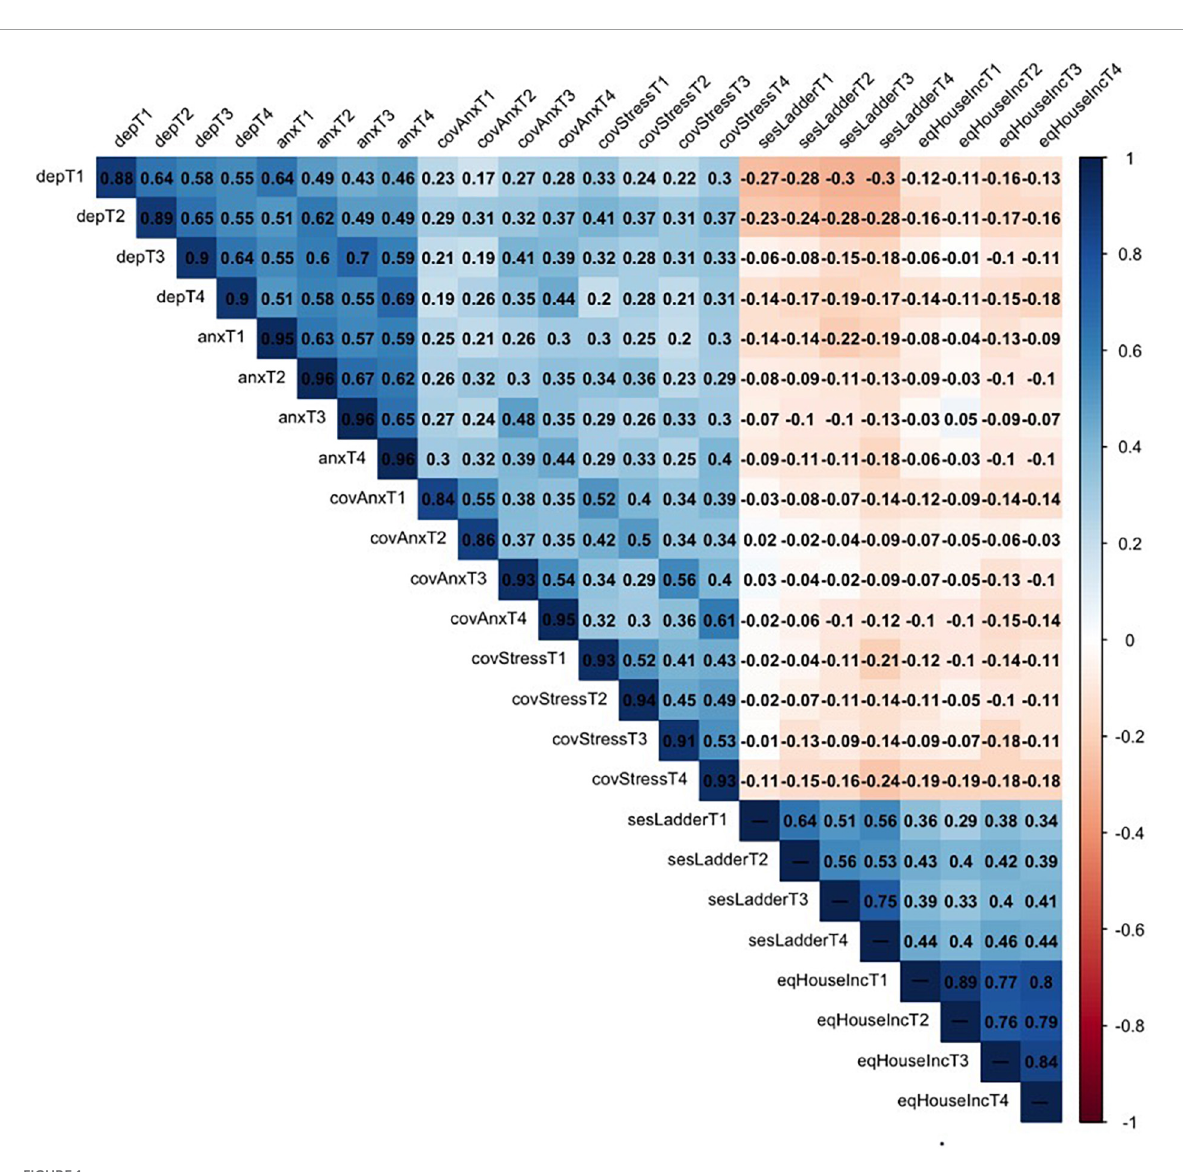
FIGURE1 Correlation matrix and reliabilities. The reliablilities of the scales are presented on the